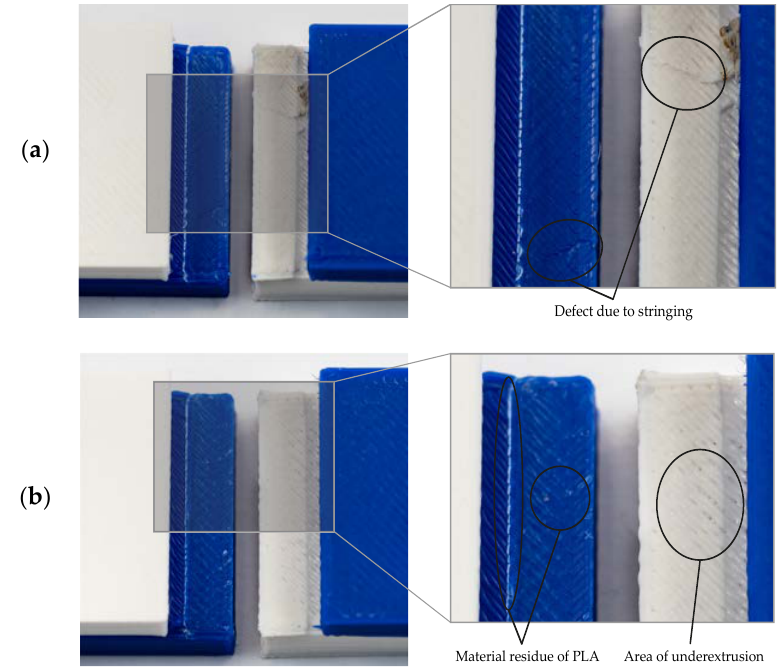
Figure 9. Failure pattern of multi-material lap-shear specimen 3 made of PLA (white) and ABS (blue) ( a ), and specimen 4 ( b ) with illustration of both, minor defects due to stringing and underextrusion and material residue of PLA on ABS surface.